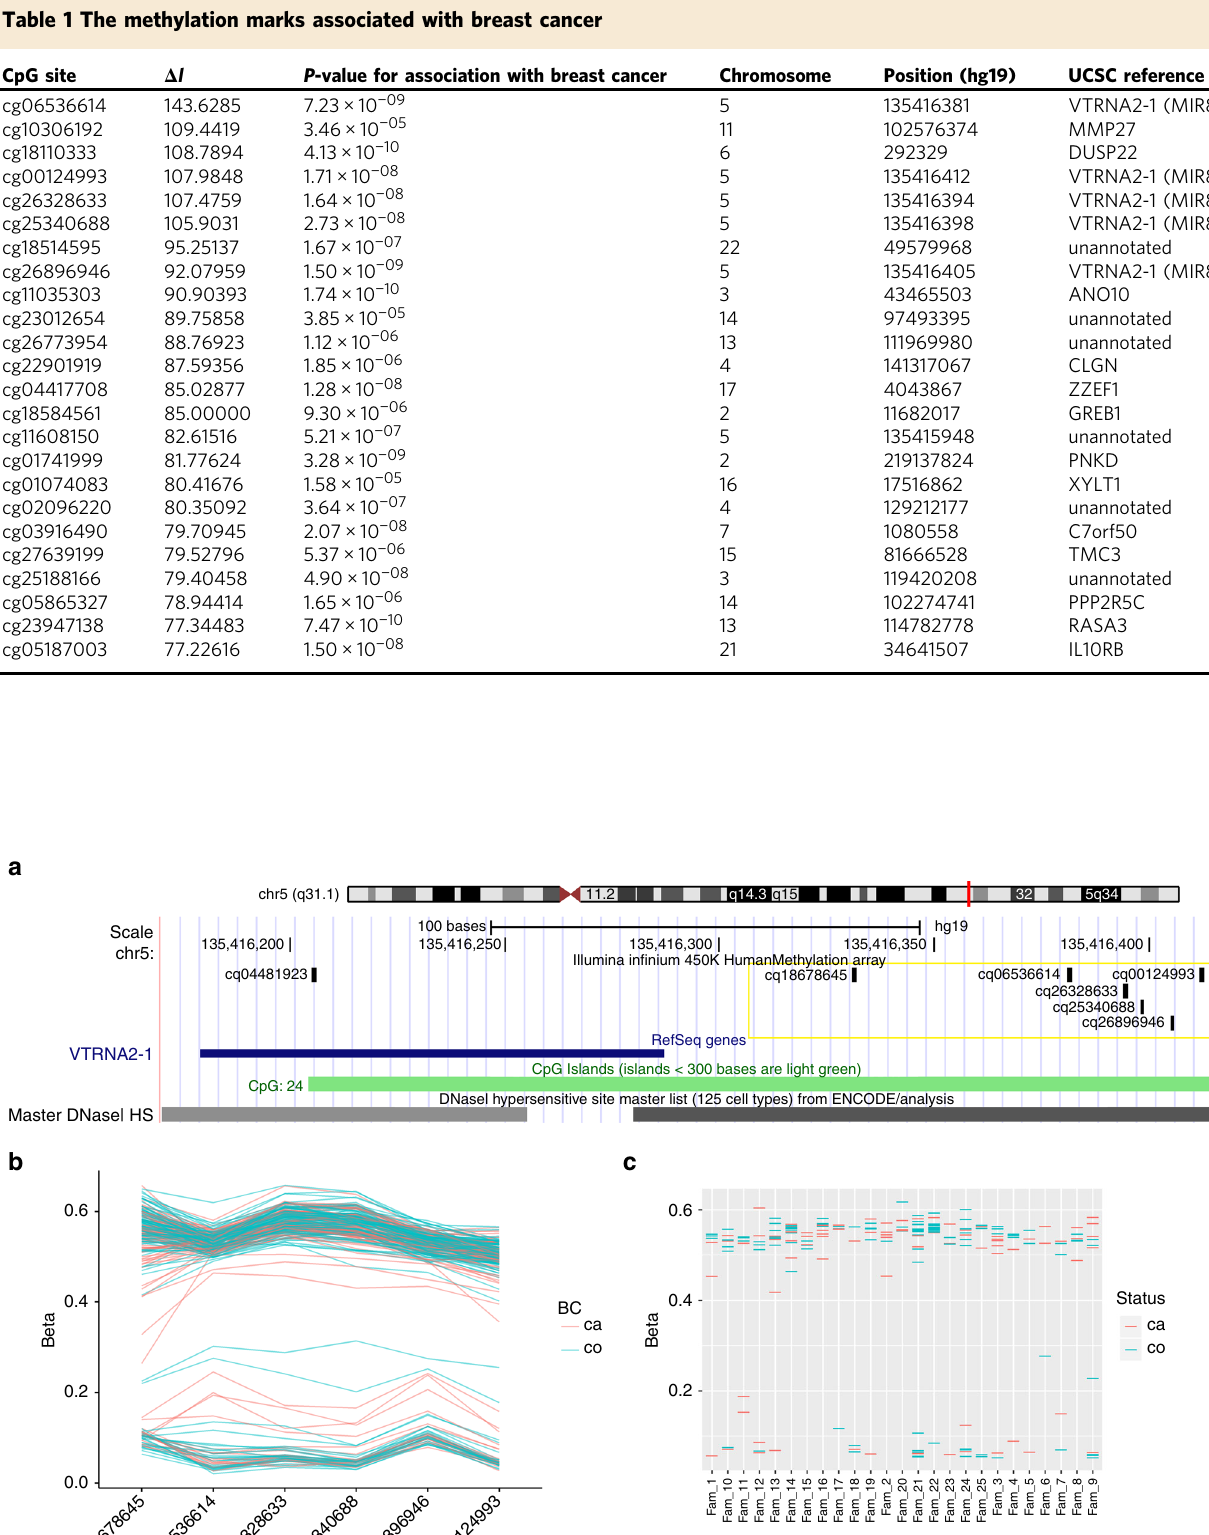
Table 1 The methylation marks associated with breast